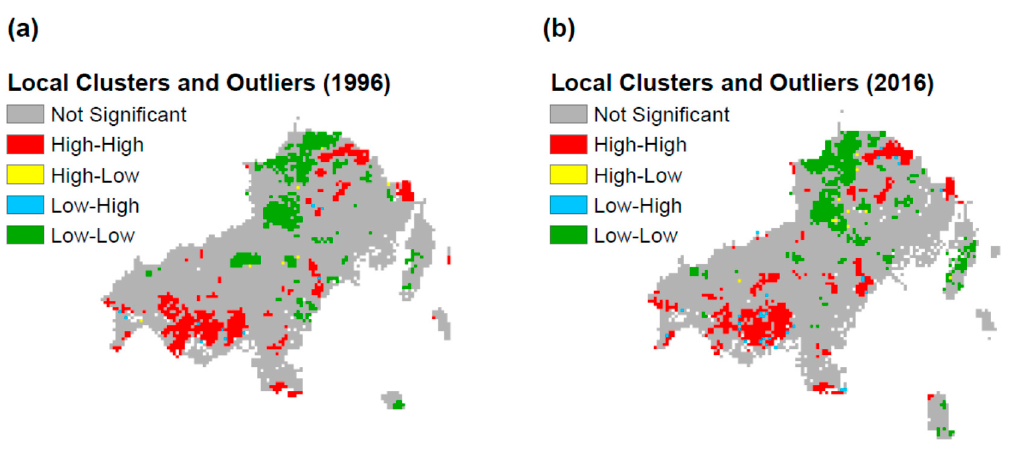
Figure 6. ( a ) Local Indicators of Spatial Association 1996, and ( b ) Local Indicators of Spatial Association 2016.